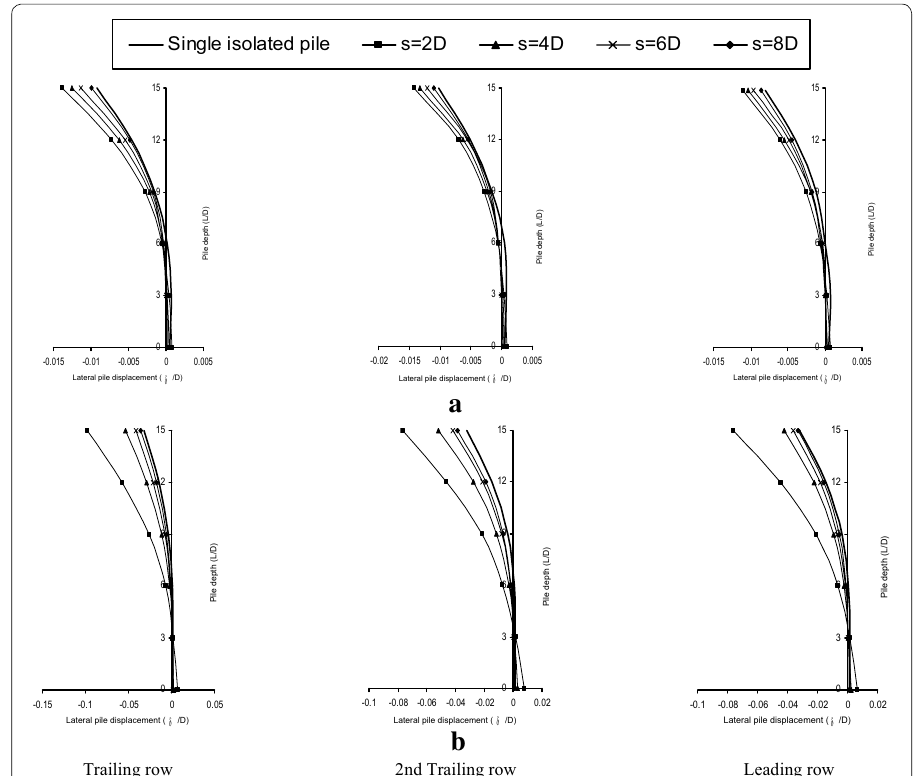
Fig. 5 Influence of pile spacing on the lateral pile displacement with depth of group piles (3 sionless soil and b cohesive